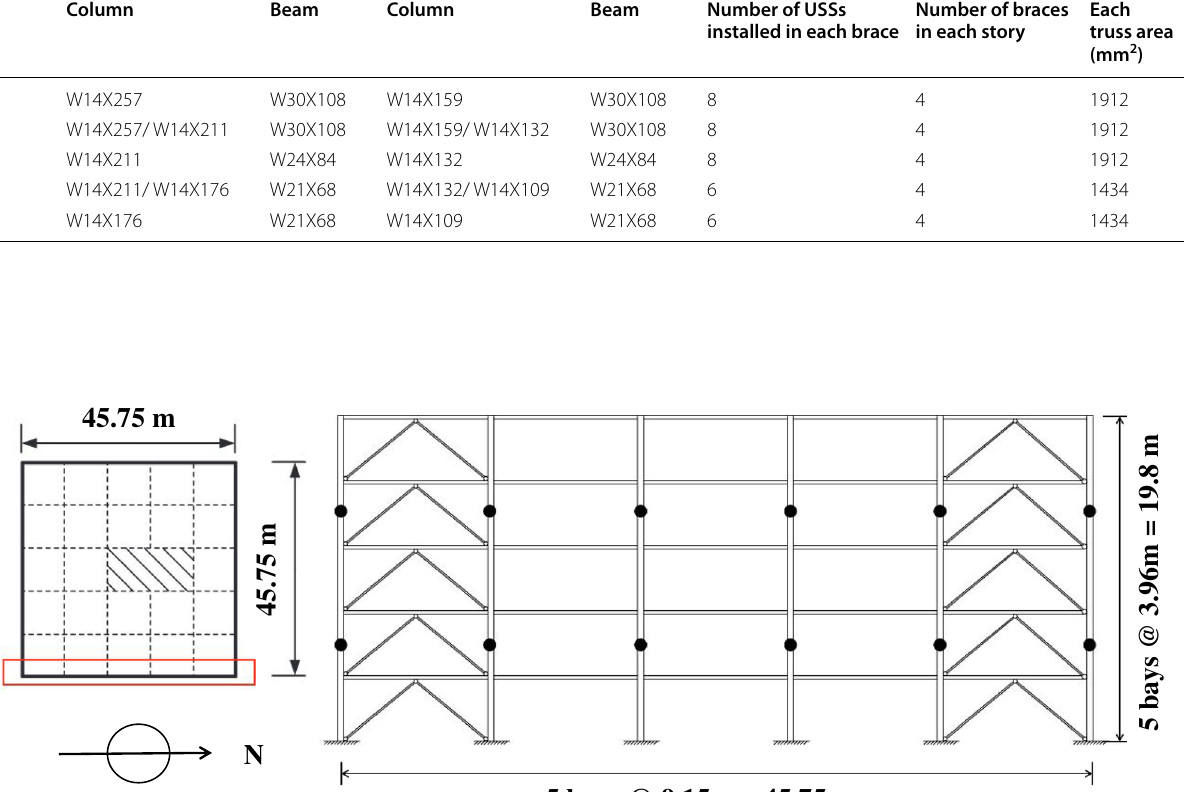
Fig. 21 Illustration of 5‑story prototype